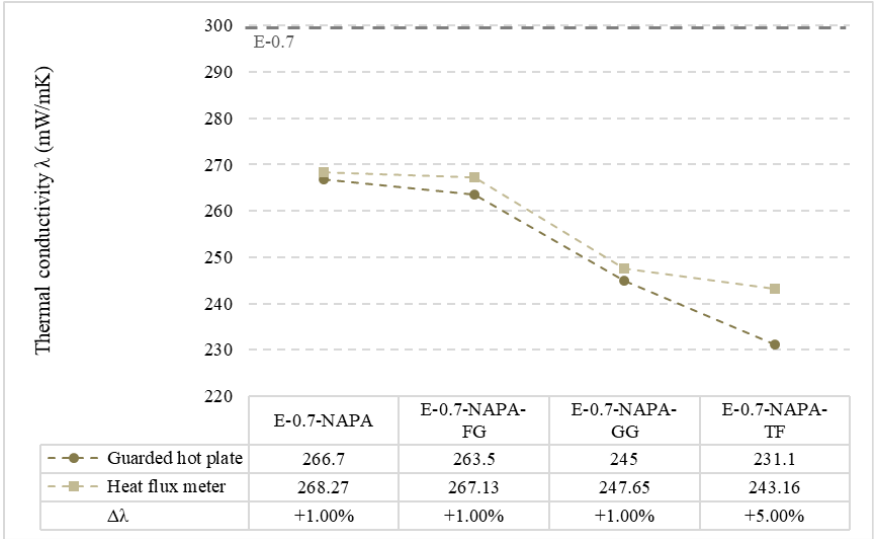
Figure 20. Measured thermal conductivity values comparison (mW/(m·K)).